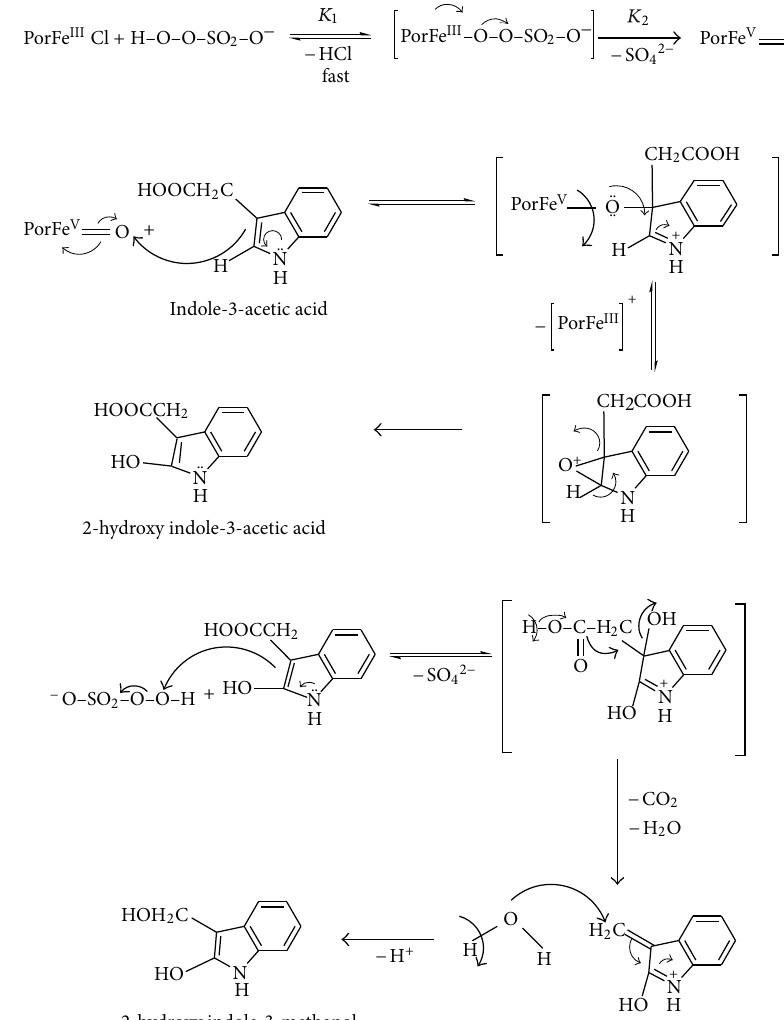
S 1: Probable mechanism for the low concentration of meso -tetraphenylporphyrin iron(III) chloride catalysed oxidation of indole by peroxomonosulphate.